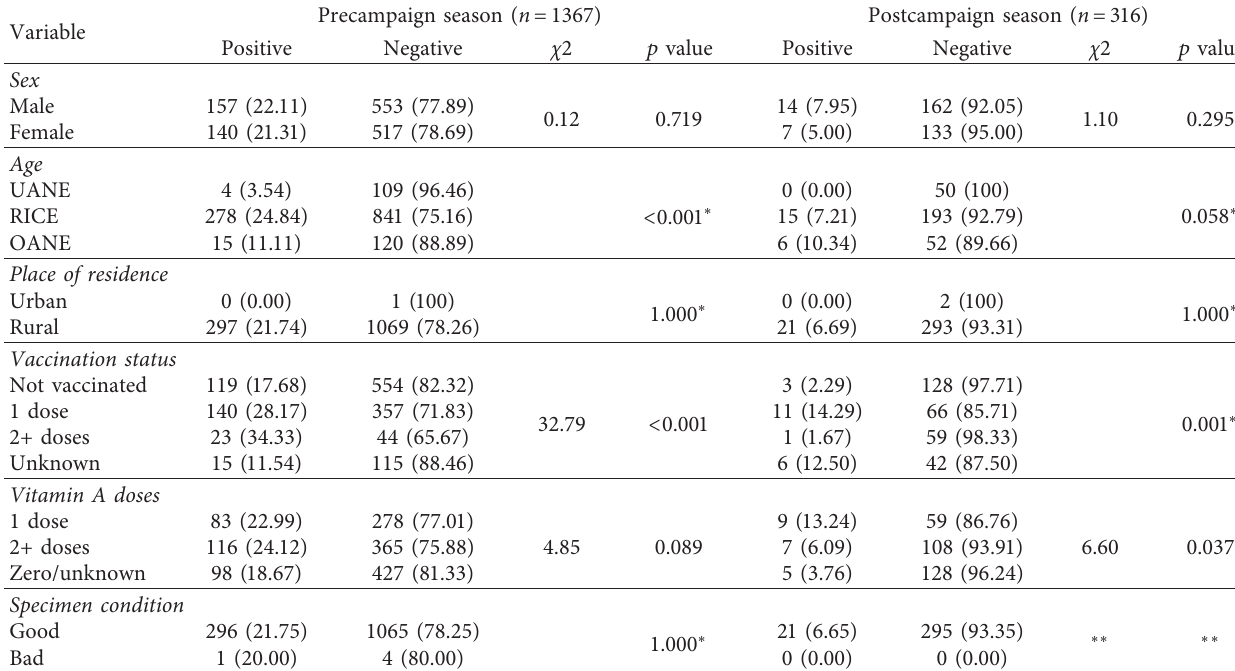
Table 3: Factors associated with the rubella outcome among laboratory-examined cases before and after the 2019 measles-rubella mass vaccination campaign.